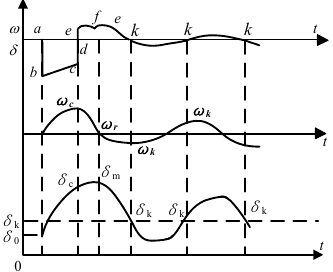
Figure 4. Oscillation process.